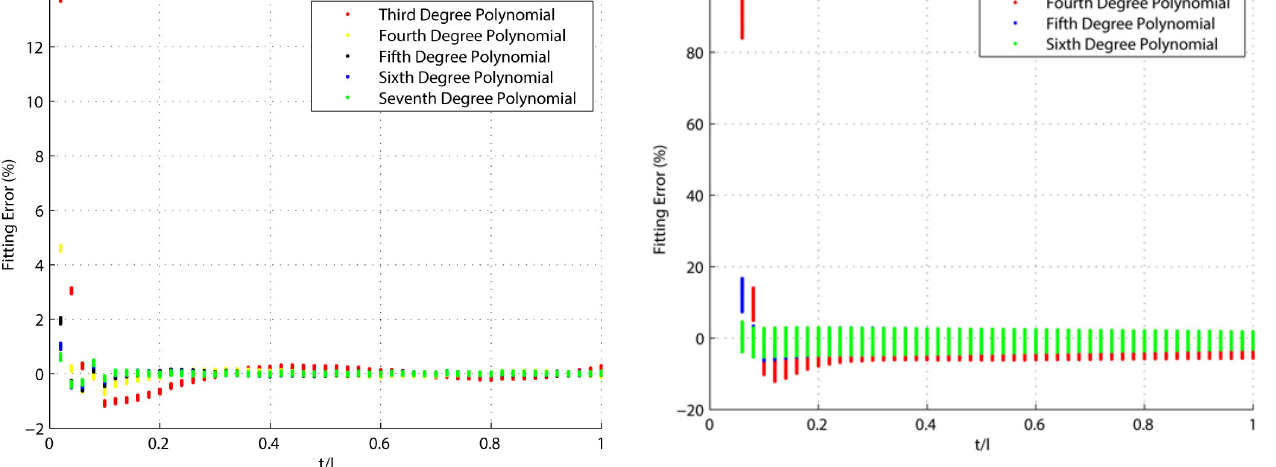
Figure 8. Fitting errors.